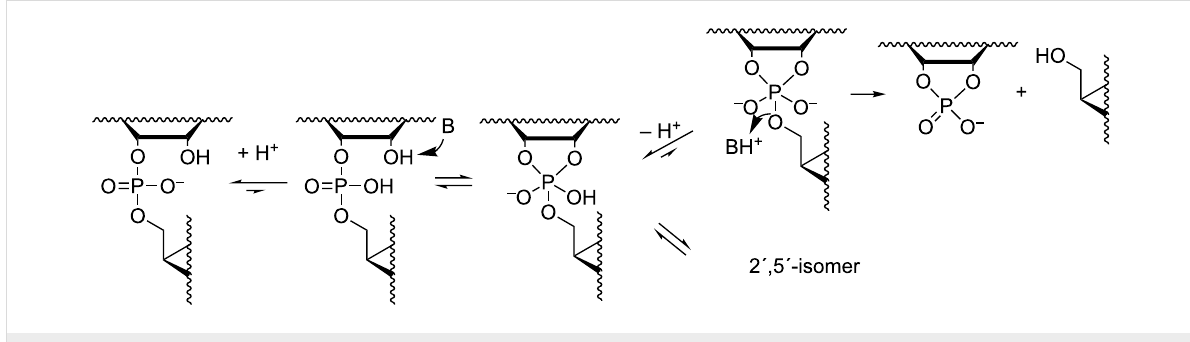
Scheme 4: Anslyn's and Breslow's mechanism for the buffer-catalyzed cleavage and isomerization of RNA phosphodiester linkages [59].